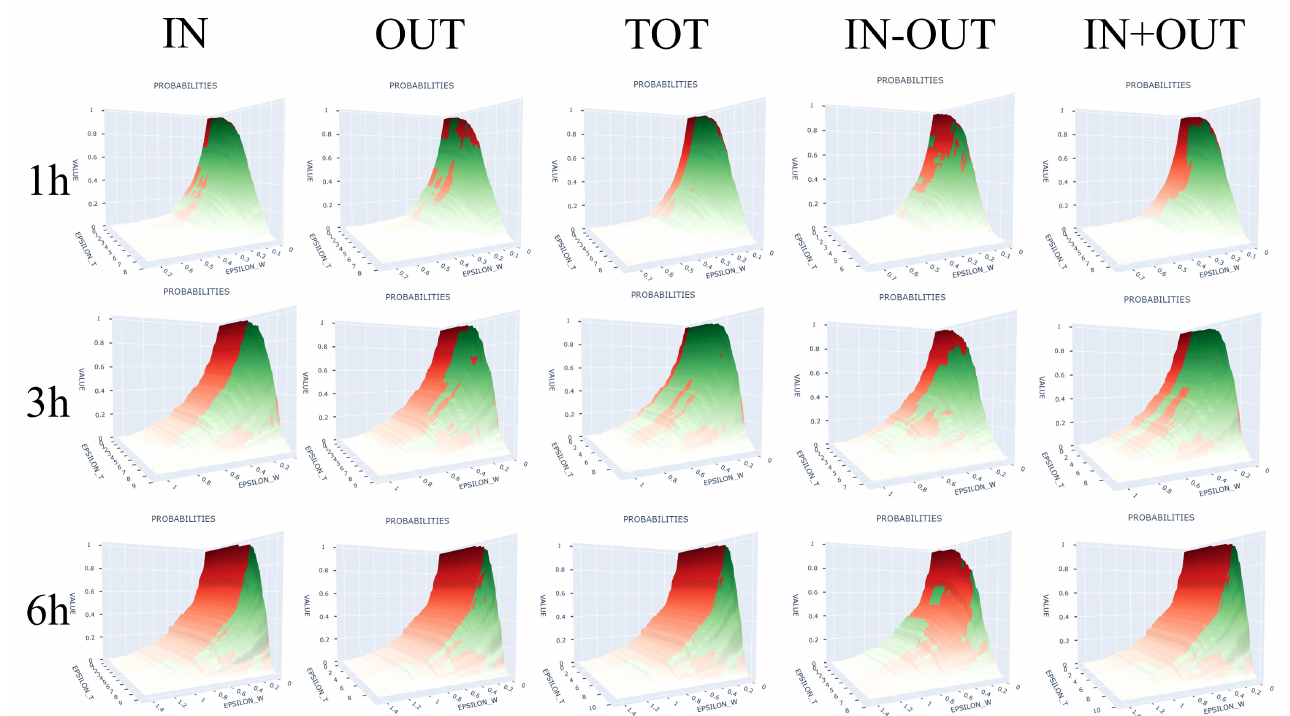
Figure 3. Joint probability values (green) and product of marginal probabilities (red) for incoming (IN), outgoing (OUT), total (TOT), difference of incoming and outgoing (IN-OUT), sum of incoming and outgoing (IN+OUT), and all values 0 < (cid:101) W < (cid:101) ∗ non-negative